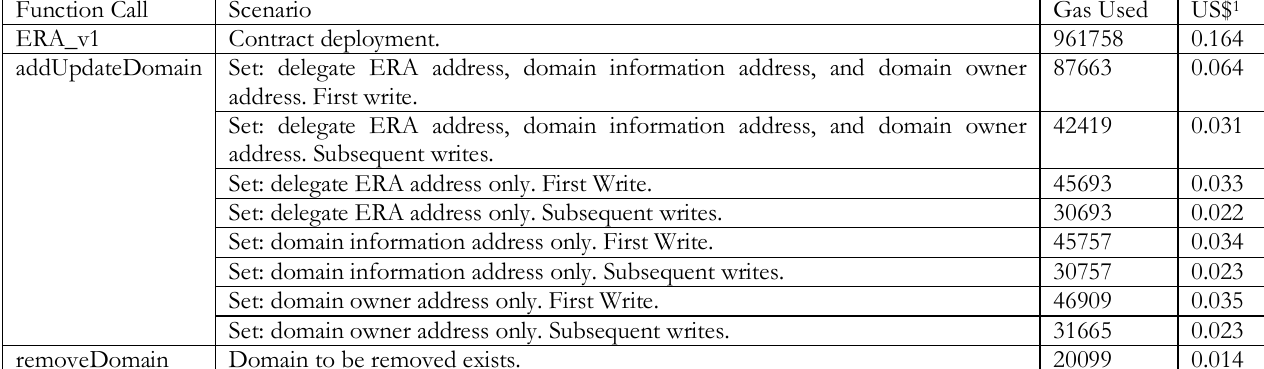
Table 1. Gas cost for calls to ERA_v1.sol implementation.